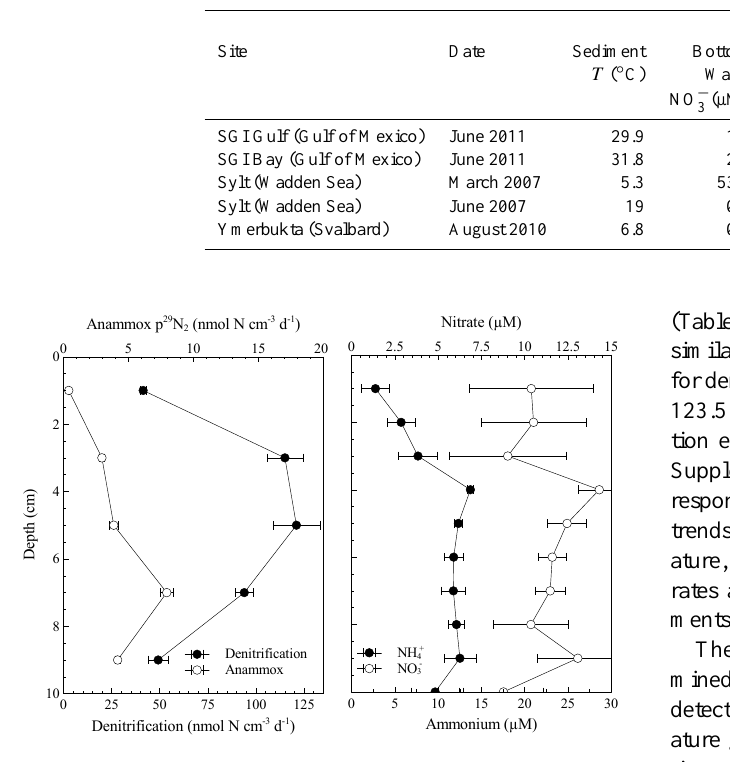
Fig. 2. Left: depth resolved potential rates of denitrification and anammox from Sylt in June 2007. Experiments using 15 NO − 15 NH + tracers were used to estimate denitrification and anammox, 4 respectively. Right: pore water profiles of nitrate and ammonium from Sylt in June 2007. Error bars represent the standard error of 3 replicate